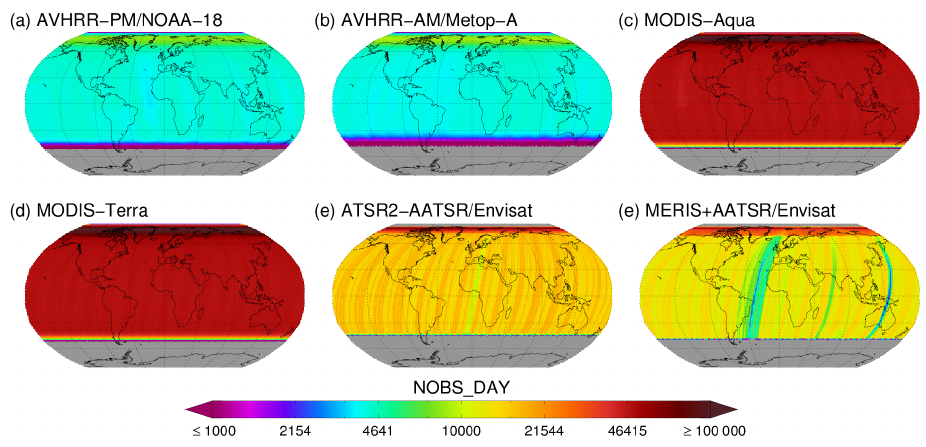
Figure 3. Number of daytime observations (pixels) per 0.5 ◦ grid cell for June 2008 and (a) AVHRR-PM/NOAA-18, (b) AVHRR-AM/Metop- A, (c) MODIS-Aqua, (d) MODIS-Terra, (e) AATSR and (f) MERIS + AATSR. For the sake of comparability only the daytime number is shown because no night-time observations are included in MERIS + AATSR. Grey-shaded areas indicate regions with no daylight and thus without daytime